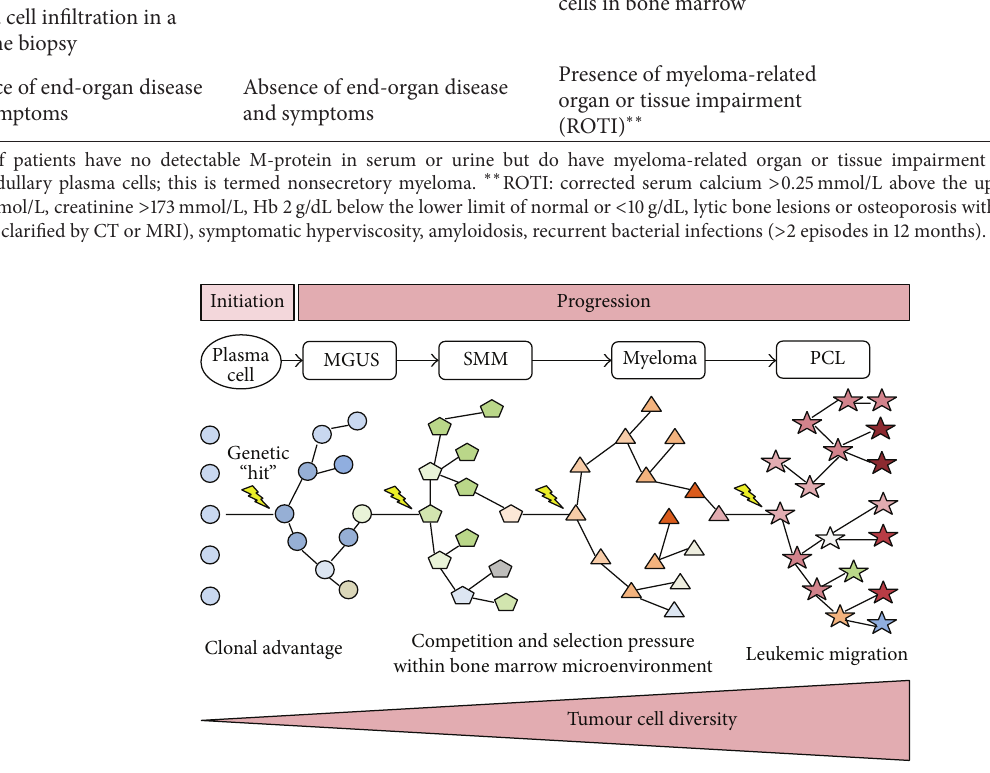
Figure 1: Initiation and progression of myeloma . A postgerminal centre B cell receives a genetic “hit” which immortalizes the cell and initiates transition to the indolent phase of monoclonal gammopathy of undetermined significance (MGUS). MGUS clones may then transition through the other disease phases of smouldering multiple myeloma (SMM), myeloma, and plasma cell leukemia (PCL) as genetic “hits”, which confer a survival advantage and are acquired over time. Clonal evolution develops through branching pathways whereby numerous ecosystems composed of multiple subclones exist at each disease phase, as represented by the differing shapes. At the end of this process, proliferative clones no longer become confined to the bone marrow and expand rapidly as a leukemic phase. At each disease phase, the precursor clones are present only at a low level as they have been outcompeted by more advantageous clones. It should be noted that the above figure represents an oversimplification of myeloma initiation and progression, as the process is highly complex with multiple pathways possible at any one time (adapted from Morgan et al., 2012